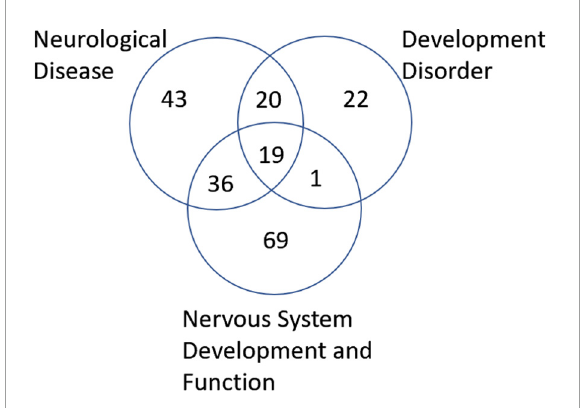
FIGURE6 Venn diagram of genes associated with neurological disease, developmental disorder, and nervous system development and function found to be altered in ASD according to IPA analysis. A total of 19 genes were found to overlap all three